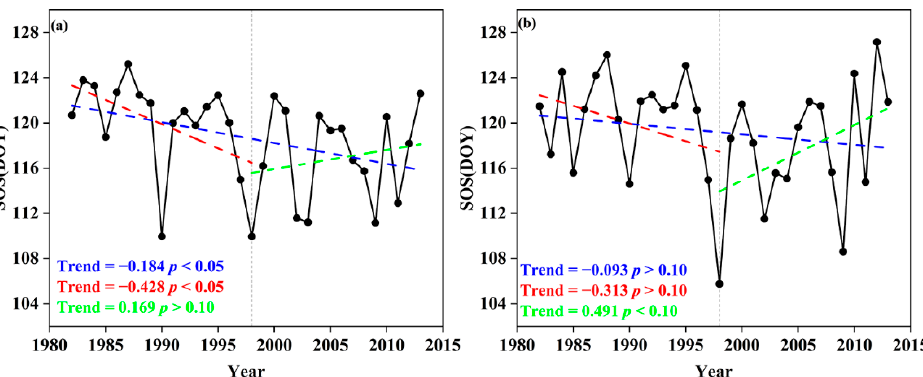
Figure 3. Trends of average SOS from 1982 to 2013: ( a ) deciduous needleleaf forests; ( b ) deciduous broadleaf forests. The solid black line represents the annual average SOS series from 1982 to 2013. The blue dashed line represents the SOS trend line from 1982 to 2013, the red dashed line represents the SOS trend line from 1982 to 1998, and the green dashed line represents the SOS trend line from 1998 to 2013.